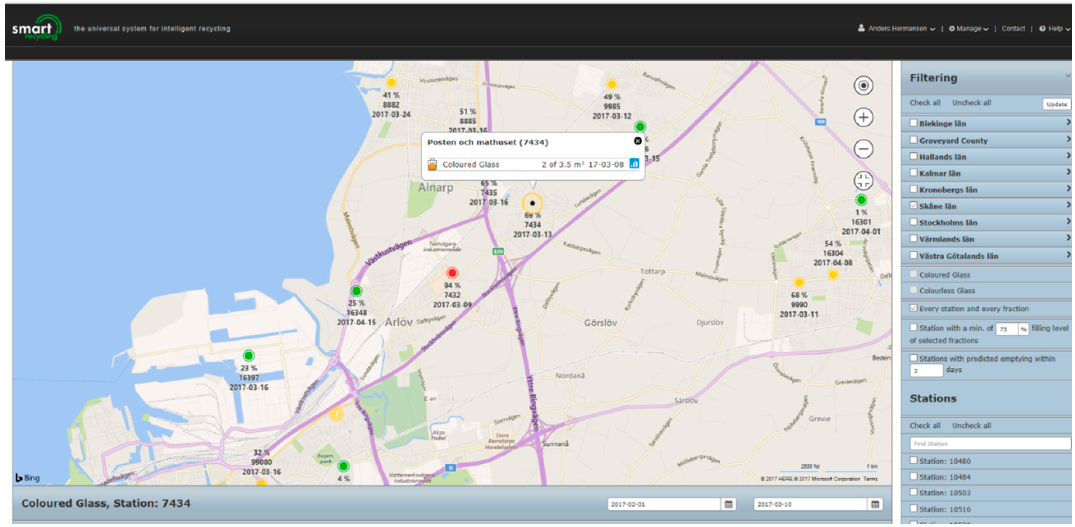
Figure 4. Visualization of a management view—high-level decision-making.